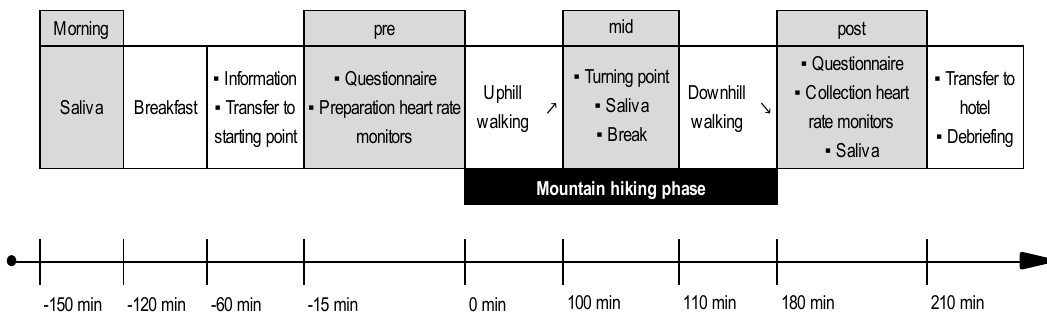
Figure 2. Experimental procedure for one condition. Grey fields mark data collection time points.